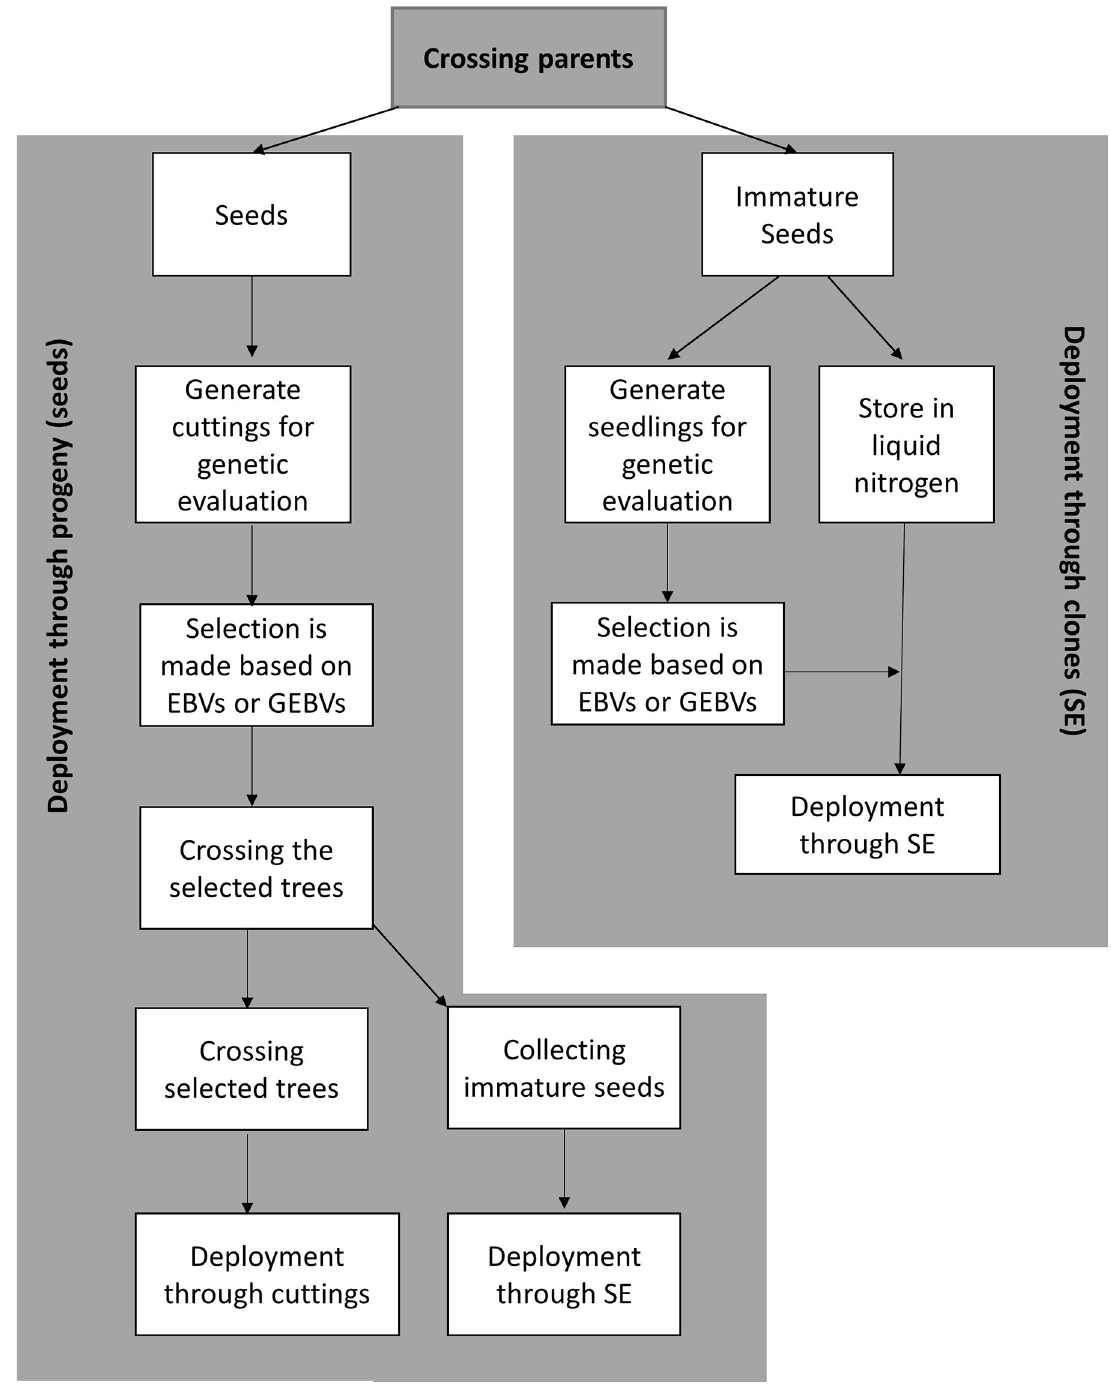
Fig 3. Two deployment options: Deployment of progeny or clones of the selected trees.